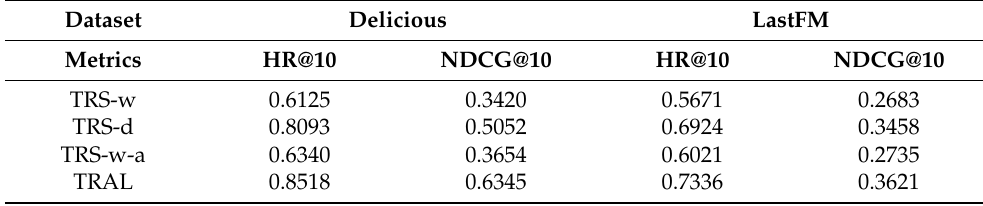
Table 4. Ablation results on the two